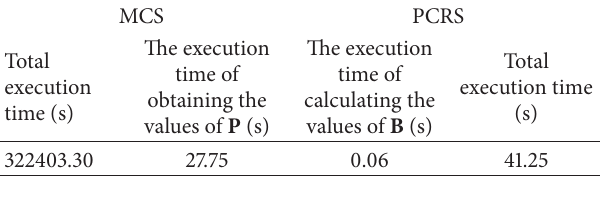
Table 2: Execution time of the MCS method and the PCRS method.